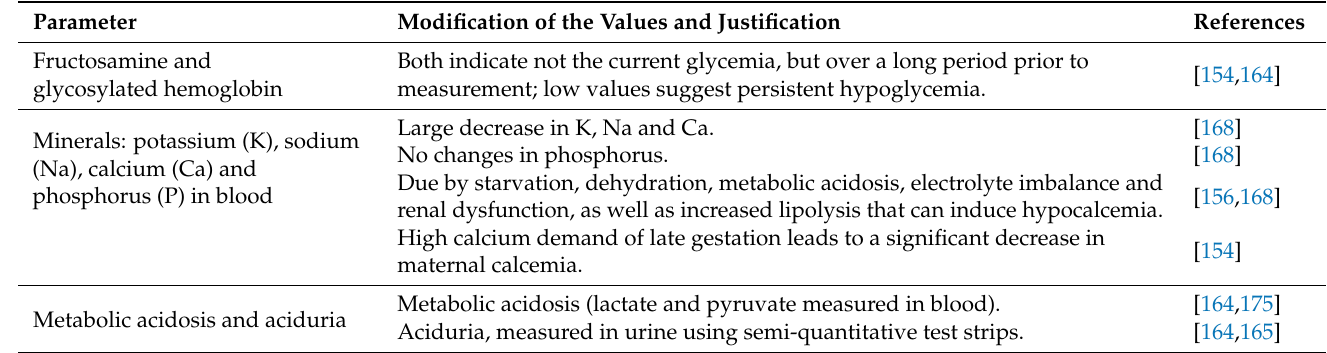
Table 3. Other, less conventional parameters measured in ewes and goats affected by pregnancy